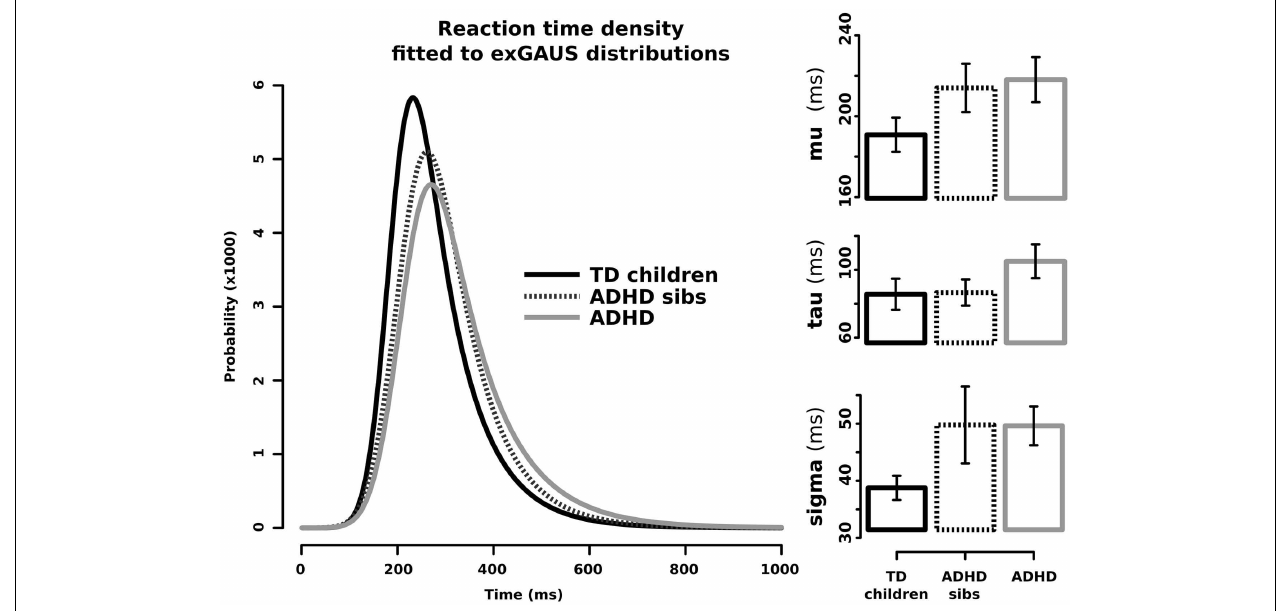
FIGURE 1 | Ex-Gaussian distributions for response times inADHD children, their unaffected sibs, and typically developing children without family history ofADHD . Left side: RT density fitted to ex-Gaussian distributions. Right side: µ (mu), σ (sigma), and τ (tau) components in the three studied groups; bars represent SE for the